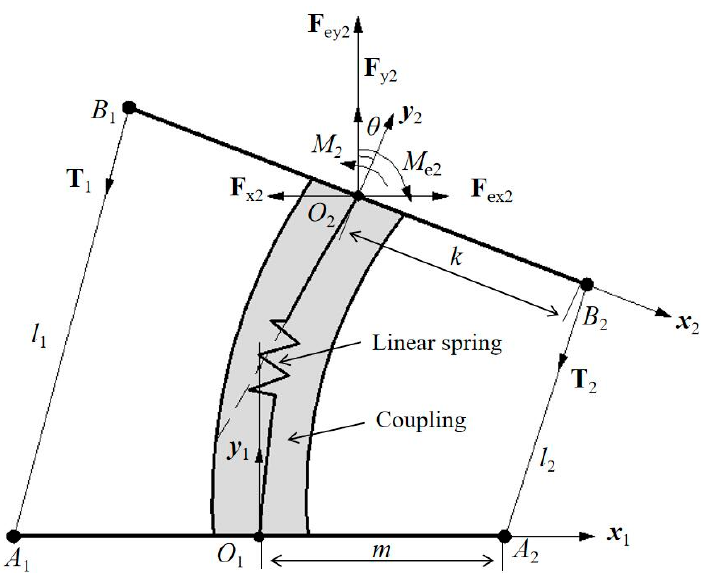
Figure 3. A model of cable-driven mechanism for the vertebra-disc unit with parameters. Two Cartesian coordinate systems are assumed on the fixed vertebra and moving vertebra as O 1 x 1 y 1 z 1 and O 2 x 2 y 2 z 2, respectively. The O 1 and O 2 are at the centers of the vertebras. The mechanism does not have motion in the Z direction, and therefore the analysis is conducted at the Oxy plane only. The rotation angle of the moving vertebra B 1 B 2 is θ as per rotating around the Z axis. A model for force analysis at the point O 2 is presented in Figure 3 yet with actions at point O 2 as F xi , F yi , and M i when i equal to 2. F x2 , F y2 , and M 2 are the forces and torque at point O 2 from the effect of linear spring; F ex2 , F ey2 , and M e2 are